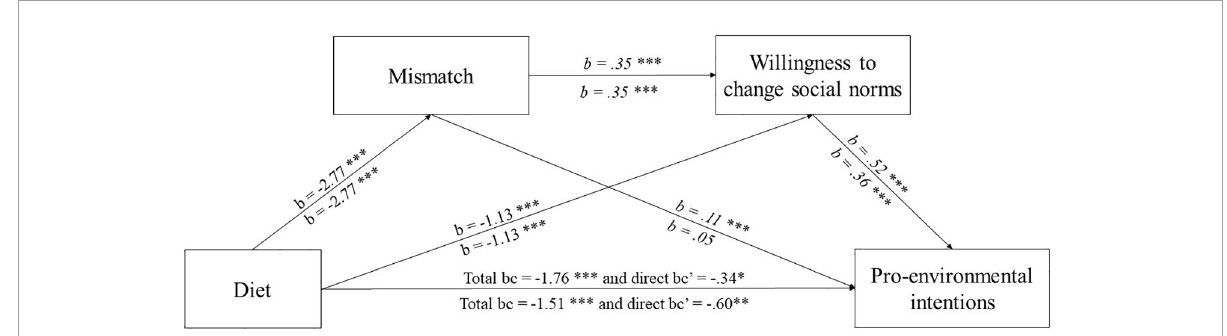
FIGURE2 Mediation model A (above the arrows) and model B (under the arrows). They were assessed using Hayes process model 6, evaluating through mismatch perception and willingness to engage in normative change as mediators of the relationship between the diet that participants followed (coded: 0 = Veg*ns; 1 = non-veg*ns); and the intentions to act against the climate change at an individual-level and the diet that participants followed and the intentions to act against the climate change at a group-level, respectively. b = unstandardized coefficients. ∗ p < 0.05; ∗∗ p < 0.01; ∗∗∗ p <